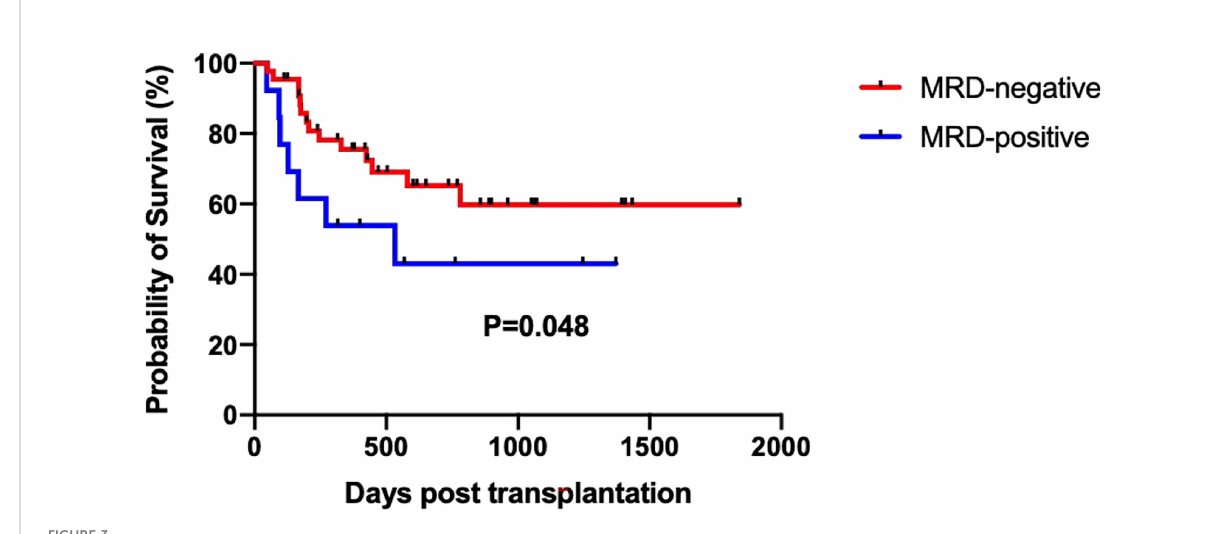
FIGURE 3 Survival of minimal residual disease (MRD)-positive and MRD-negative patients.